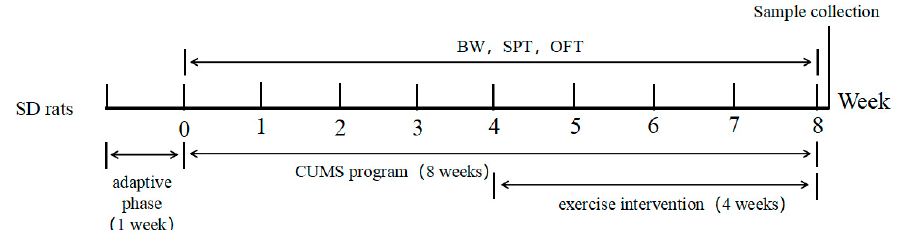
Figure 1. Experimental flow chart. BW, body weight; SPT, sucrose preference test; OFT, open field test.